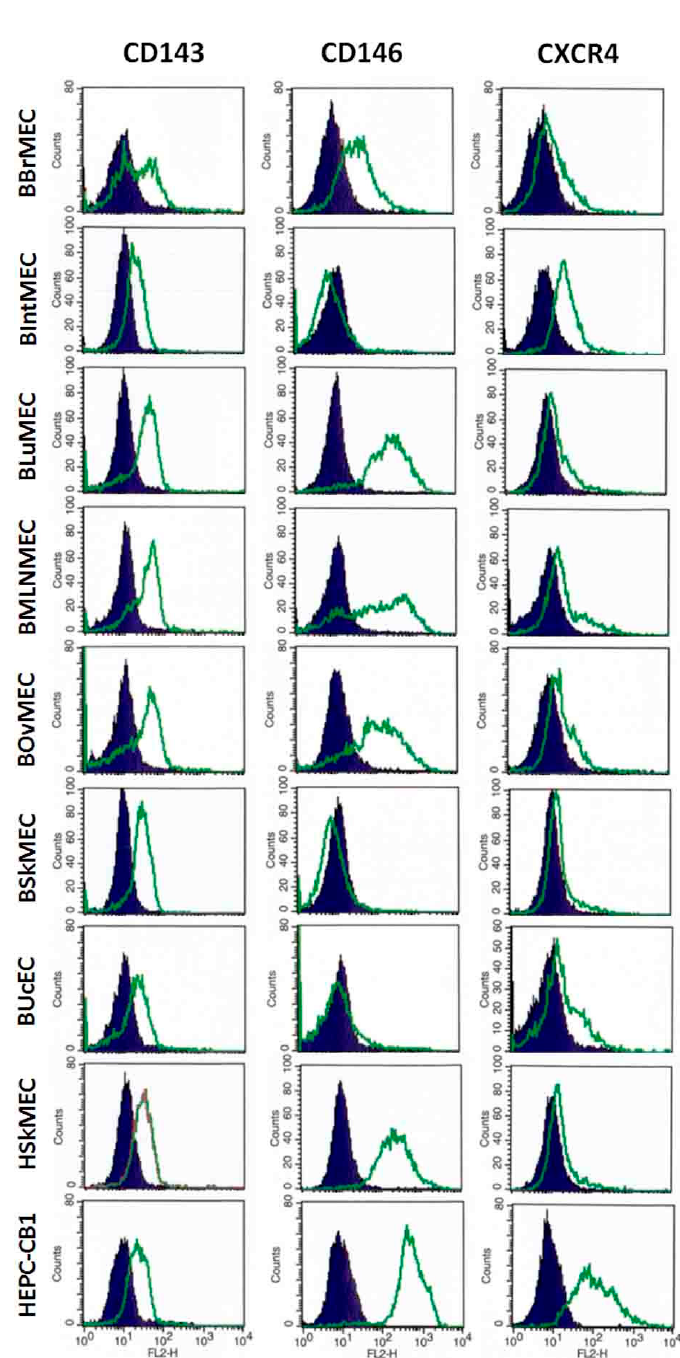
Figure 3. Main endothelial cell markers expressed in various bovine cell lines assessed by flow cytometry. Bovine endothelial cell lines and two human endothelial cell lines, as controls, were labeled with anti-CD143, anti-CD146, and anti-CXCR4 antibodies and then analyzed by flow cytometry. Results are shown as histograms showing the fluorescence intensity with the isotypic control in dark blue and the antibody labeling in green.